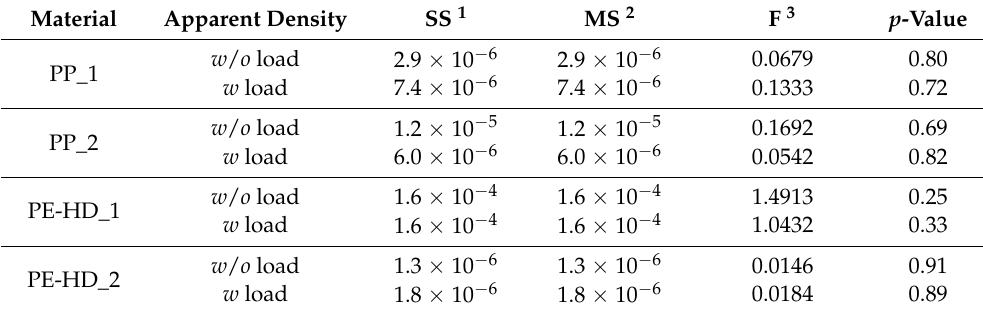
Table 4. Analysis of variance (ANOVA–single factor) between the grouped increment samples and their counterpart composite samples of the four PO feedstocks based on AD with a level of significance (a = 0.05).